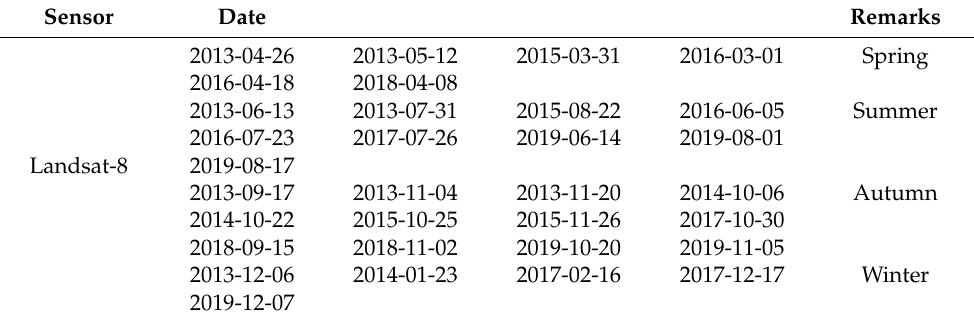
Table A1. Landsat-8 OLI/TIRS images of the Wuhan City used in this study (Section 3.2).